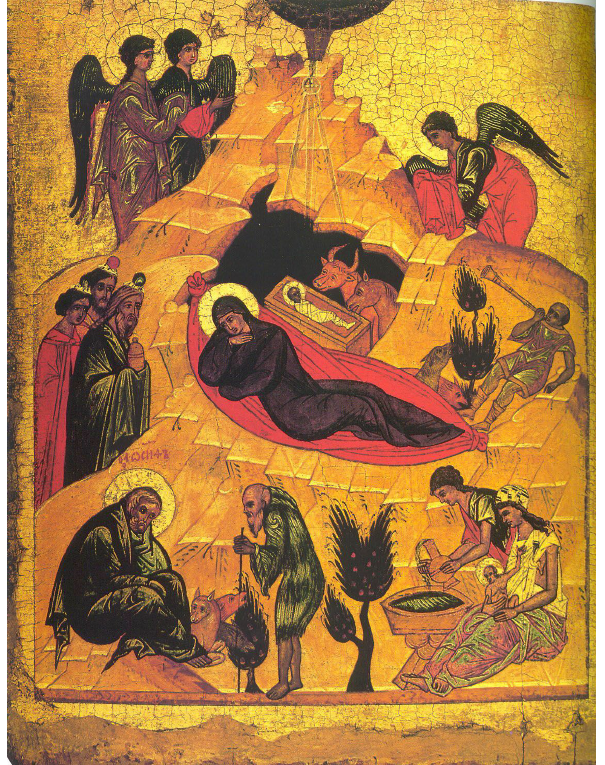
Figure 8. Nativity by Andrei Rublev. Note how the figures are one- dimensional, and the entire work lacks perspective. Painted during the first half of 14th century and now at the State Tretyakov Gallery, Moscow, Russia. Source: public domain – Wiki